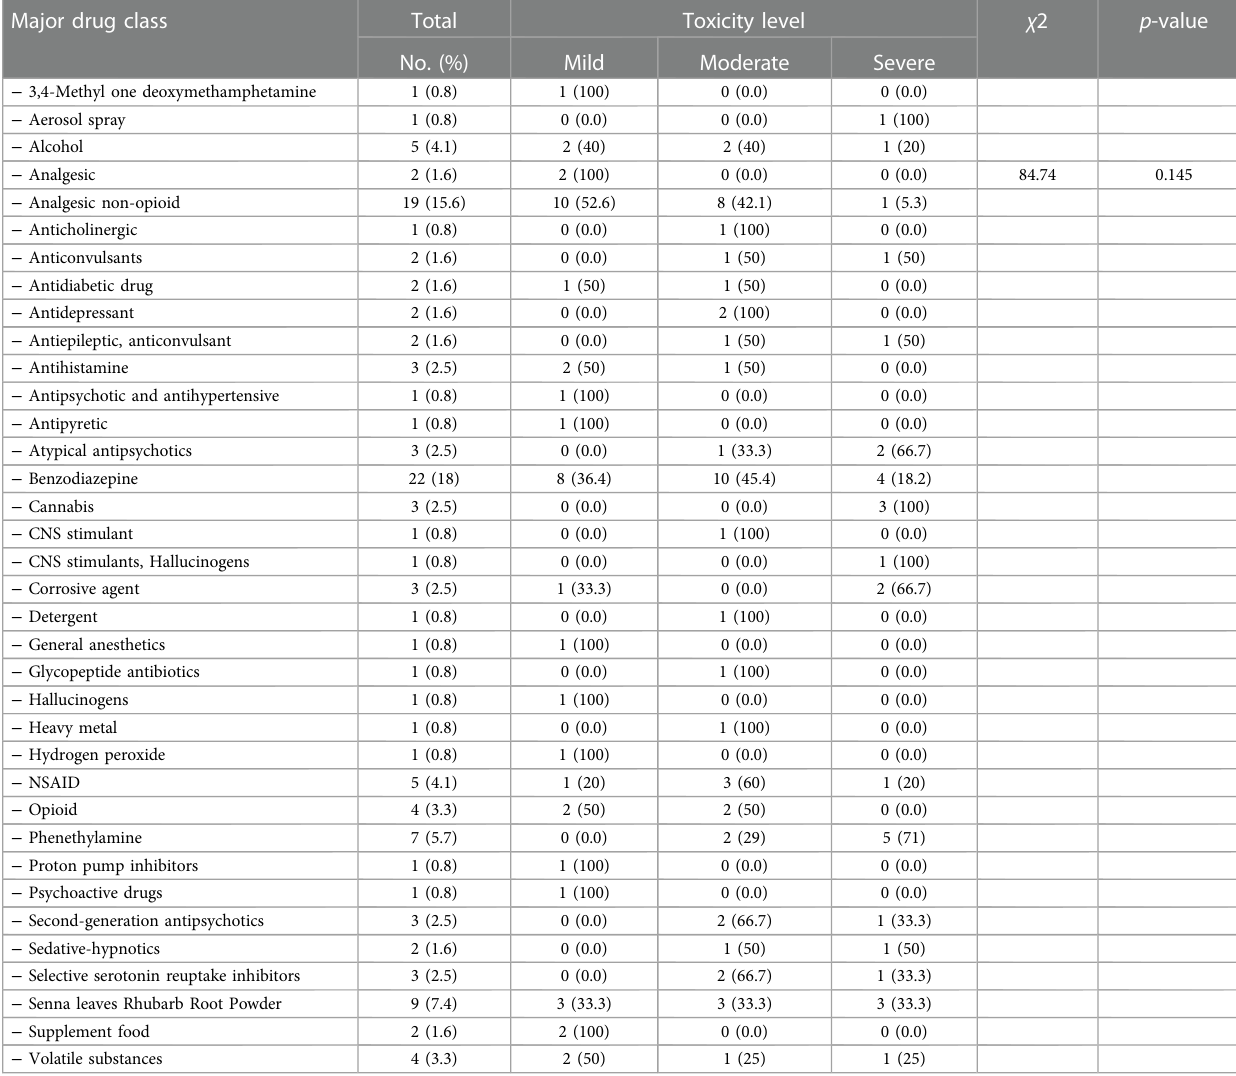
TABLE 2 Relationship between major drug ’ s class and level of toxicity. Major drug